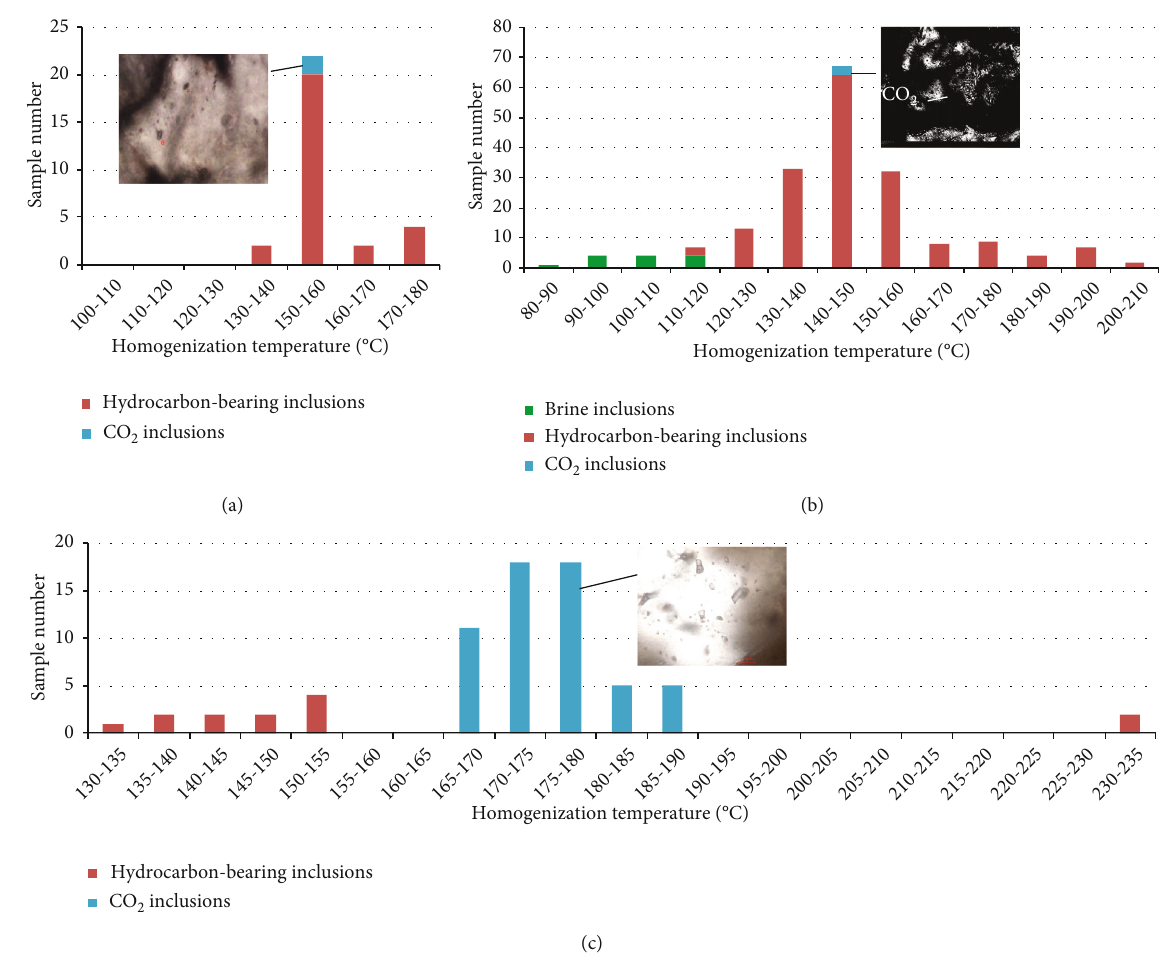
Figure 5: Homogenization temperatures of CO inclusions and hydrocarbon inclusions associated with the brine in (a) the LD10 gas 2 reservoir, (b) the HK29 gas reservoir, and (c) the BD19 gas